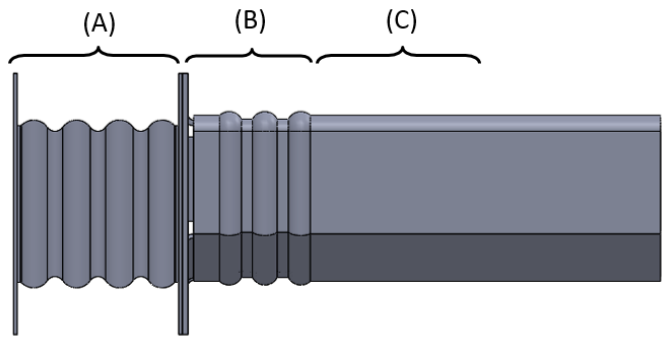
Figure 4. Parts of the proposed front rail.